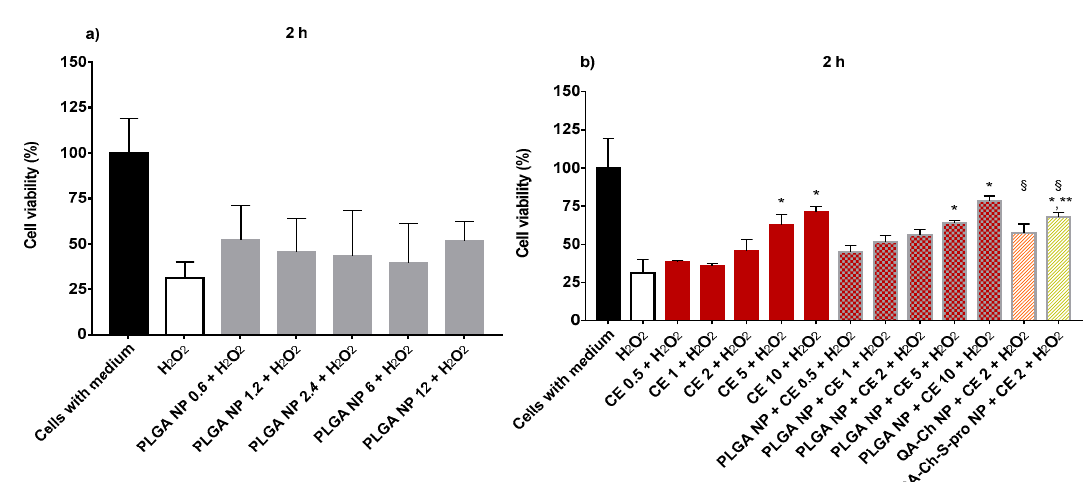
Figure 6 . Human umbilical vein endothelial cell (HUVEC) viability after 2-h treatment with empty PLGA NPs up to 12 mg/mL ( a ), non-encapsulated CE, and CE-loaded NPs ( b ) at different CE concentrations (0.5– 10 µg/mL GAE).